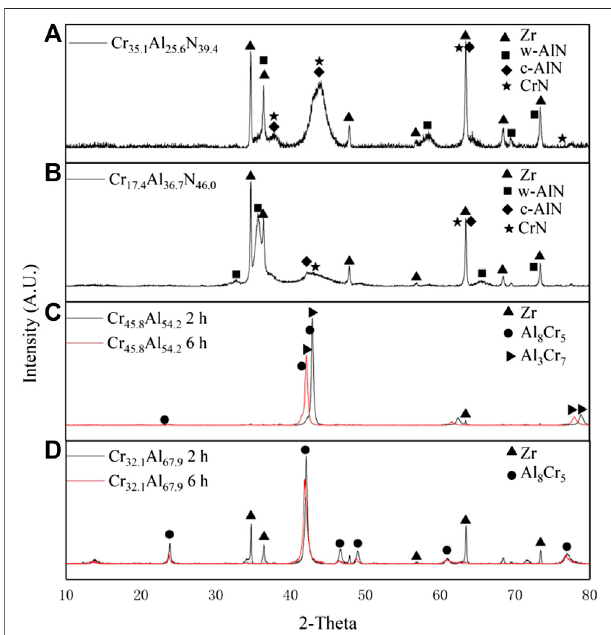
FIGURE 6 | XRD patterns of (A) Cr 35.1 Al 25.6 N 39.4 , (B) Cr 17.4 Al 36.7 N 46.0 , (C) Cr